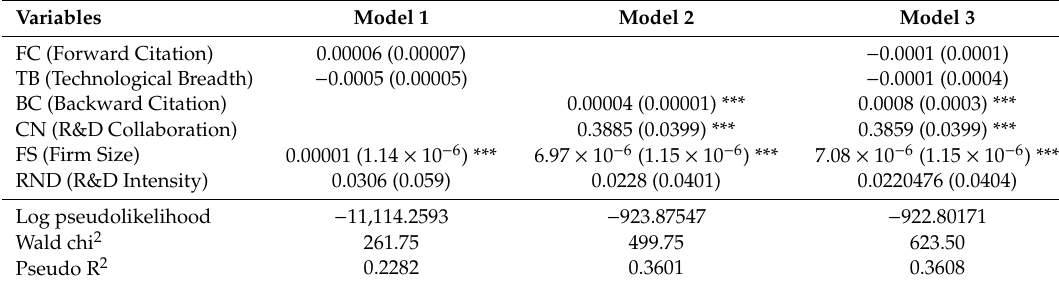
Table 3. Negative binomial regression